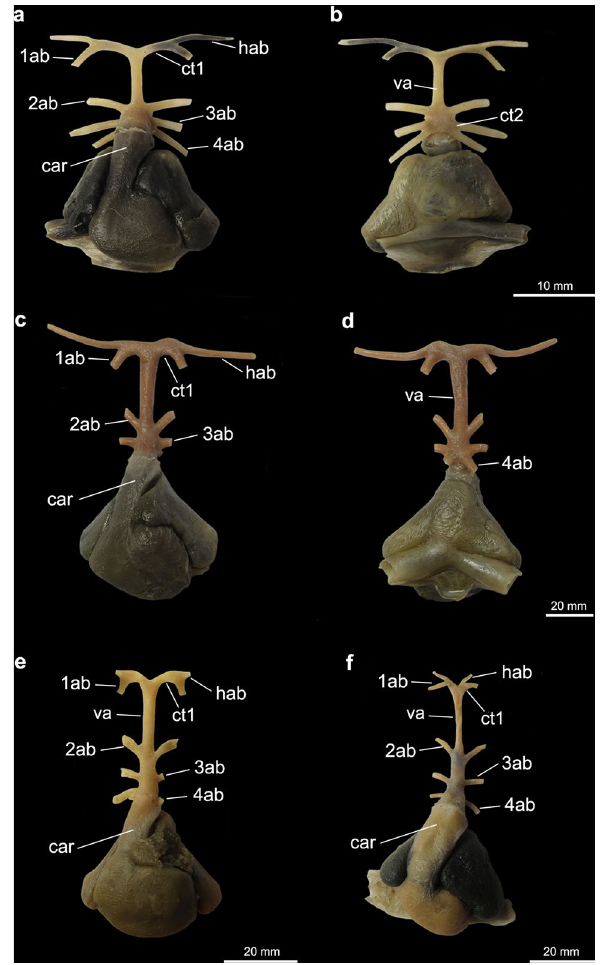
Figure 1. Heart and afferent branchial arteries in Myliobatiformes. ( a ) ventral and ( b ) dorsal views of Gymnura micrura ; ( c ) ventral and ( d ) dorsal views of Myliobatis freminvillei ; ( e ) ventral view of Urobatis halleri ; ( f ) ventral view of Potamotrygon motoro . 1ab-4ab 1st-4th afferent branchial arteries; ct1 common trunk from the ventral aorta to the hyoidean and first afferent branchial arteries; car conus arteriosus ; hab hyoidean afferent branchial artery; ct2 common trunk from the ventral aorta to the two posteriormost afferent branchial arteries; va ventral aorta.